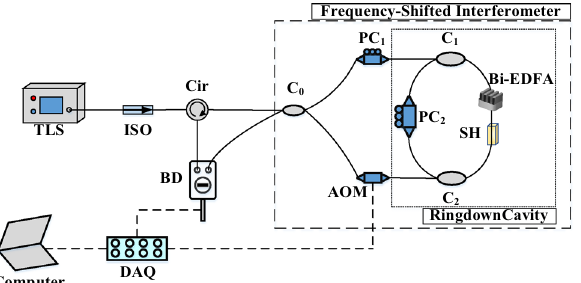
Figure 1. Schematic diagram of the space-domain active FCRD sensing system. TSL tunable semiconductor laser; ISO isolator, Cir circulator, C 0 3 dB fiber coupler, C 1 and C 2 high splitting-ratio fiber couplers, PC 1 and PC 2 polarization controllers, SH sensor head, Bi-EDFA bidirectional erbium-doped fiber amplifier, AOM acousto- optic modulator, BD balanced detector, DAQ data acquisition